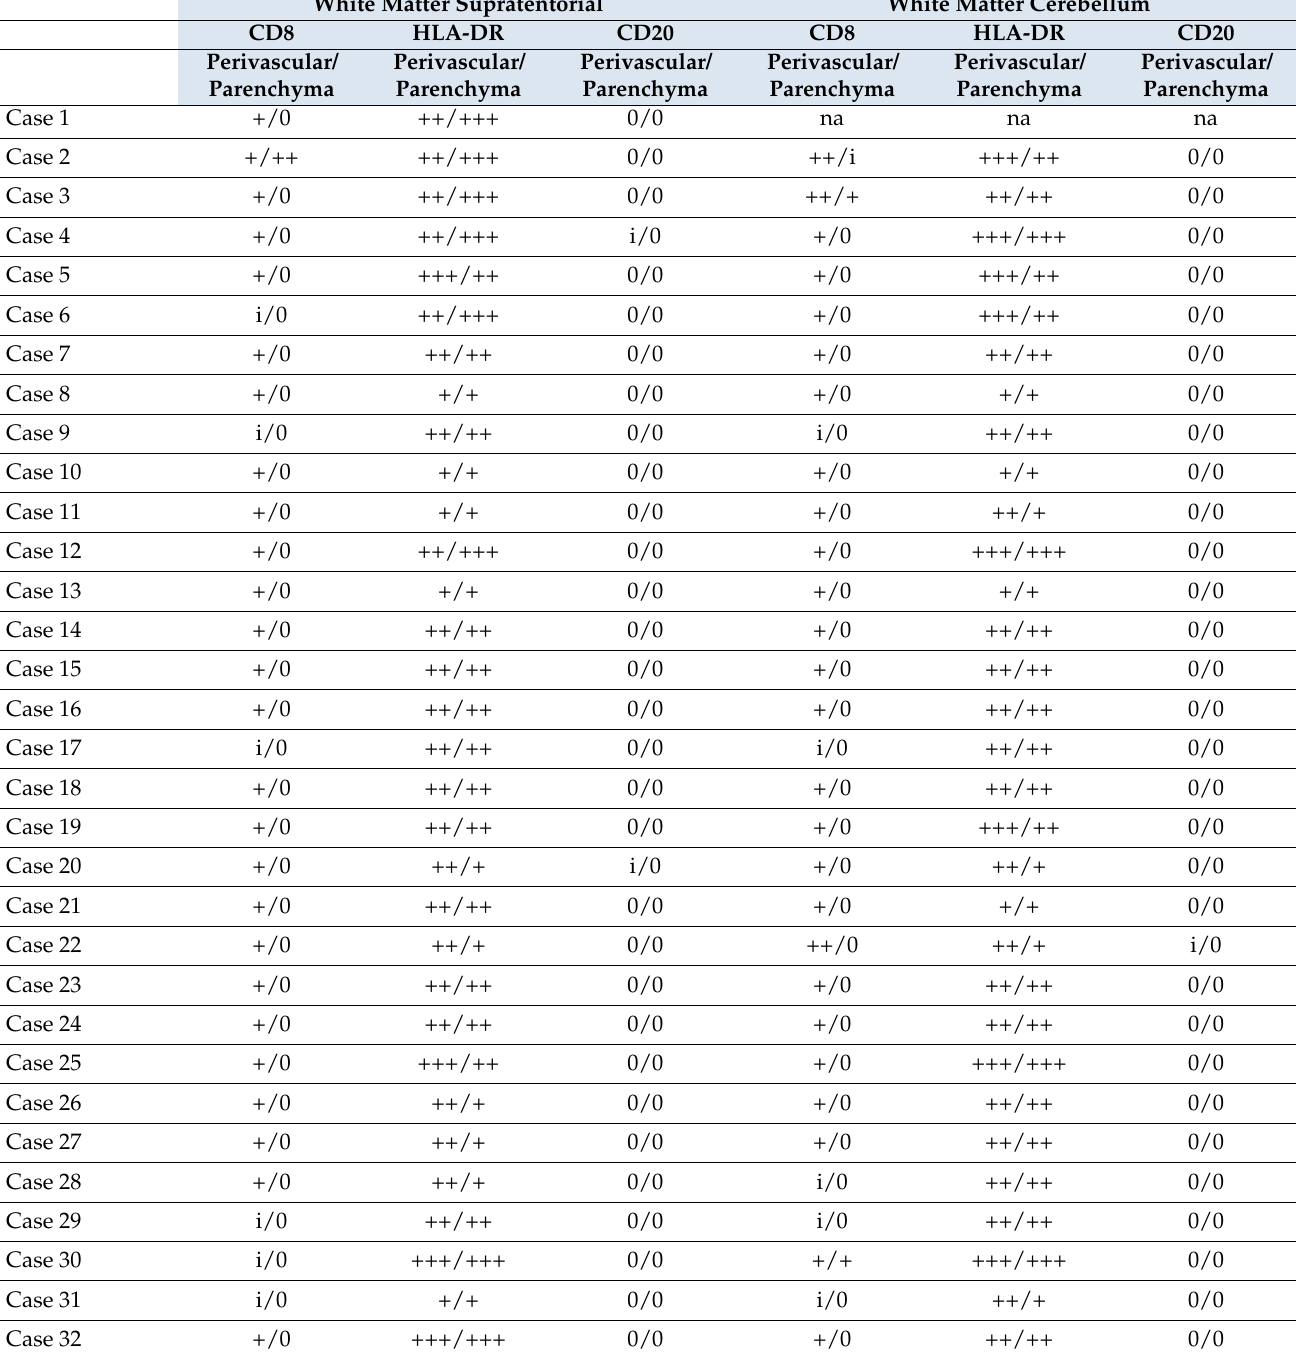
Table 3. Global distribution of inflammatory cells in supra- and infratentorial white matter (0 = absent, i = isolated, + = mild, ++ = moderate, +++ abundant; for scoring details please see Section 2). White Matter